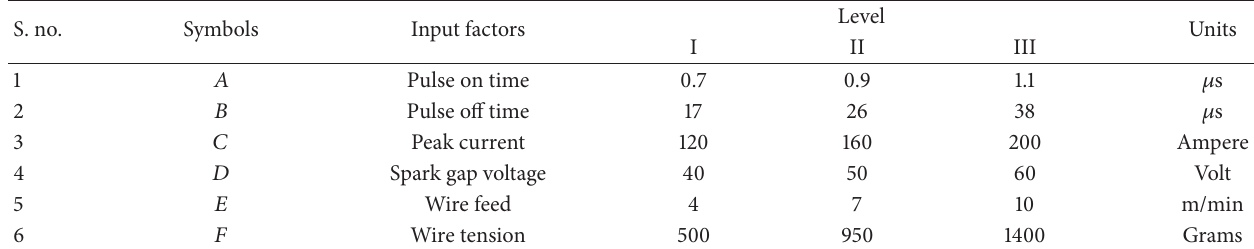
Table 1: Factors and their